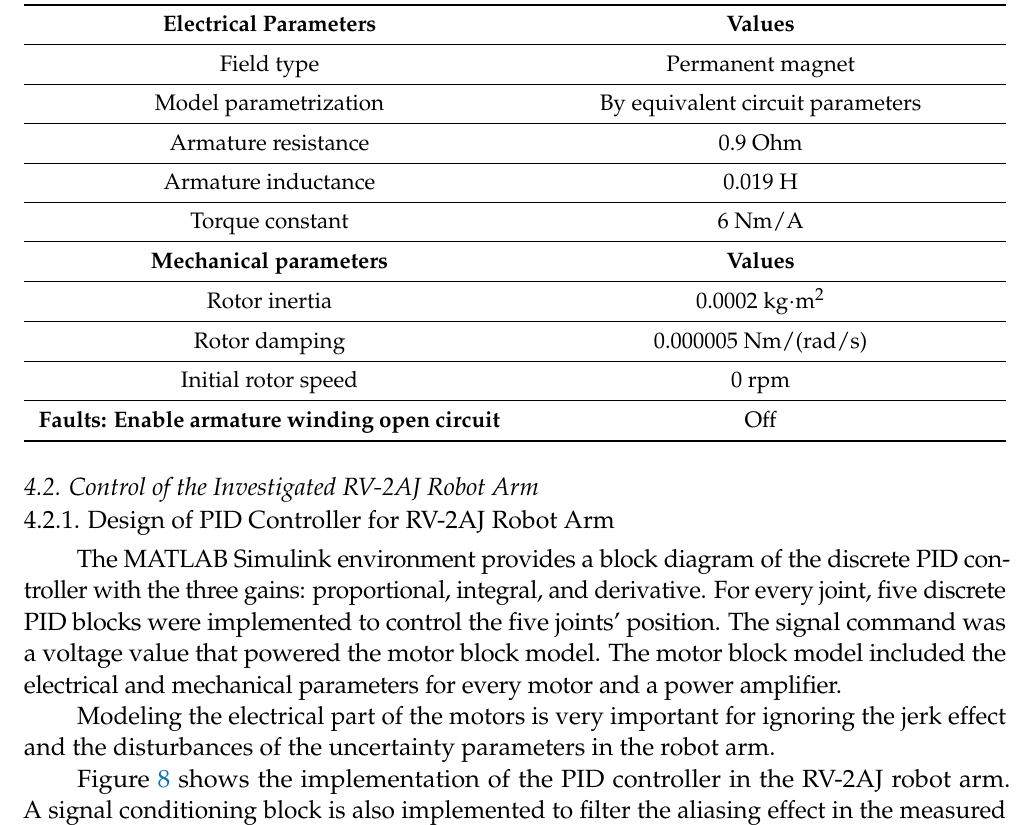
Figure 7. Dynamics of RV-2AJ arm using Simscape Multibody toolbox. Table 3. Electrical and mechanical parameters of the DC motor.